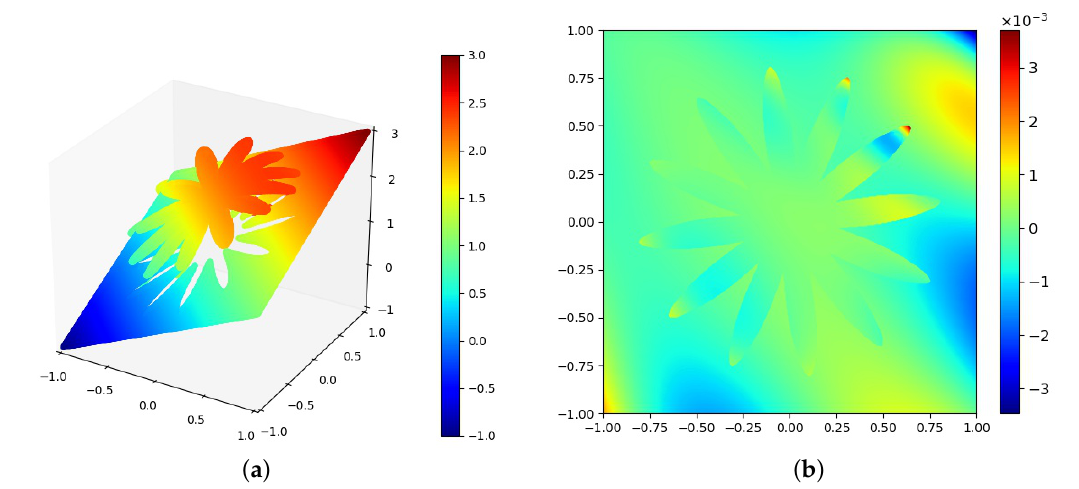
Figure 6. ( a ) The PINN solution and ( b ) the error between PINN and the exact solution for Example 2.